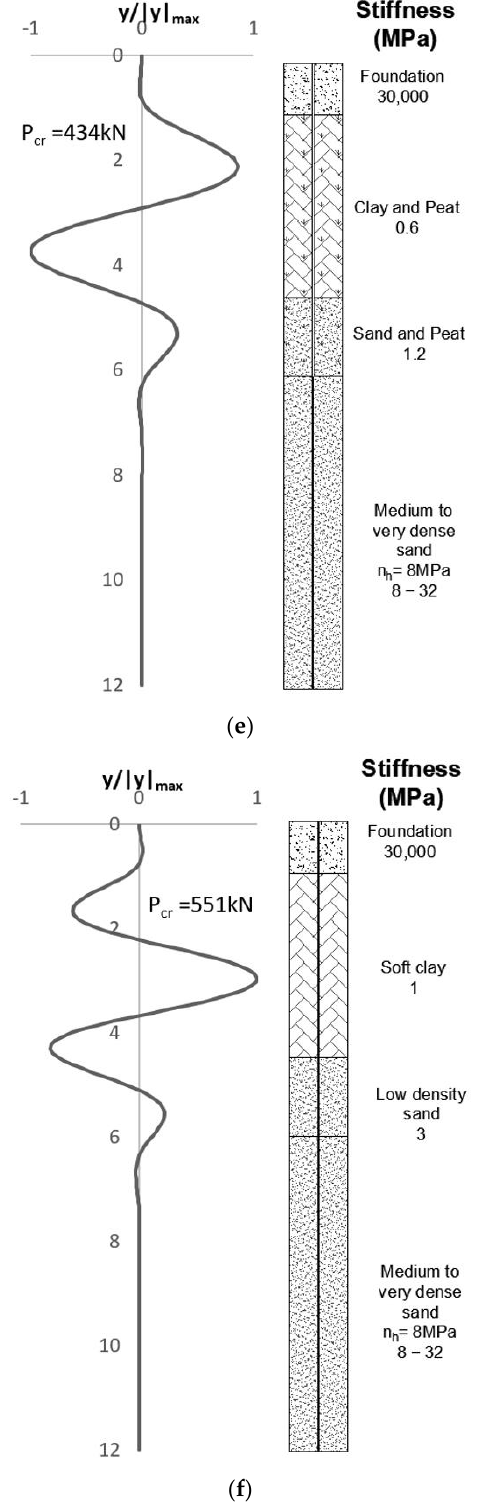
Figure 6. Examples of second-order displaced shapes and buckling load of piles in multi-layered soil conditions with: ( a ) two not-embedded segments, i.e., stilt houses; ( b ) bottom of the pile is not embedded in hard rock; ( c , d ) same configuration of soil layers with only an inversion of the sedimentation order of the two soft soils; ( e ) presence of clay and peat layers surrounding the pile without crossing any caves; ( f ) soft clay with no cavities and peat